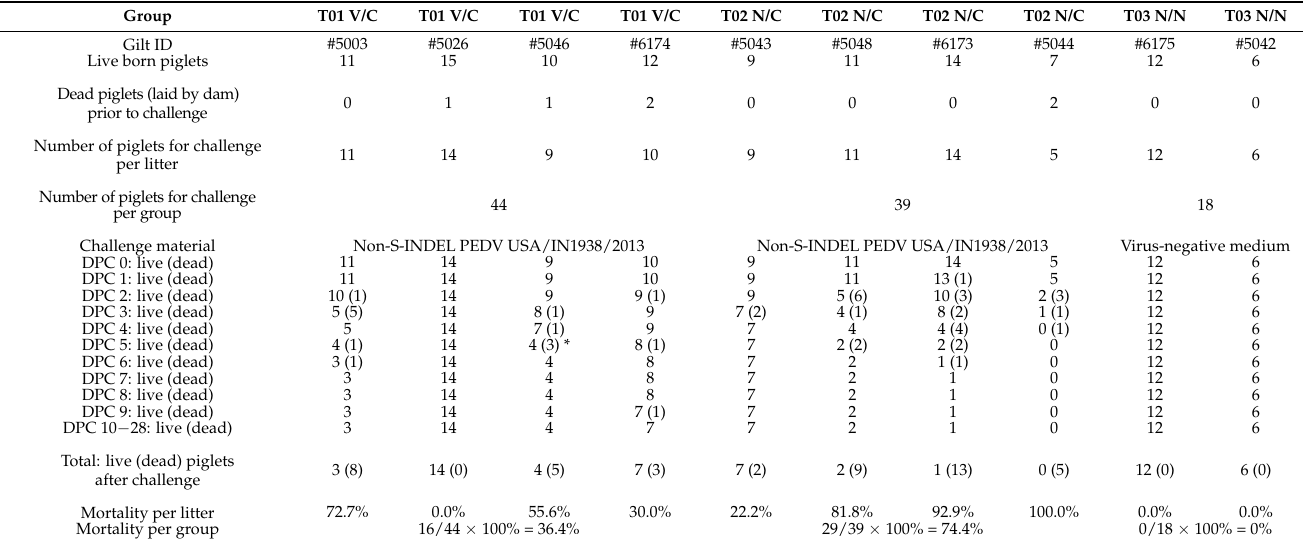
Table 4. Summary of live and dead piglets at birth and after PEDV